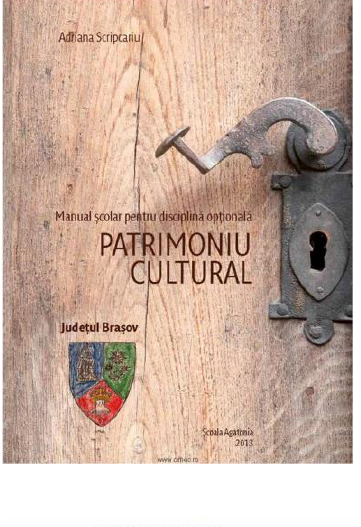
Figure 5: Left page: Descriptions of traditional craftsmanship – pottery and icon painting; Right